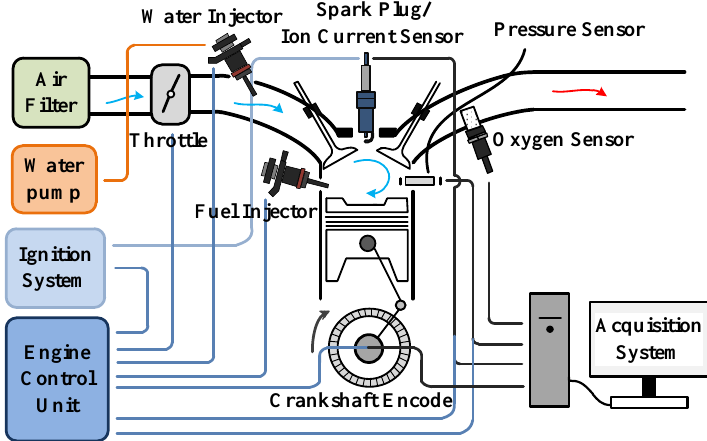
Figure 5. The schematic diagram of engine test bench.